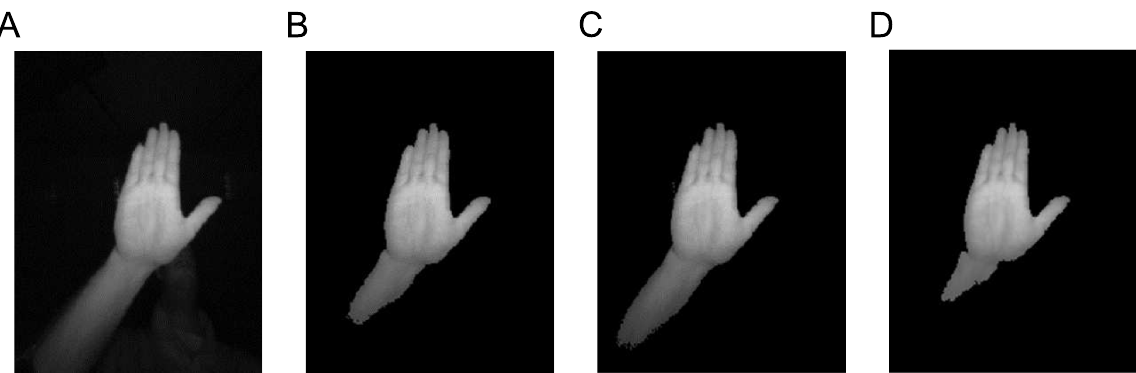
Fig 4. Hand image segmentation with three different thresholds. (A) original image, (B) result with Otsu’s threshold, (C) result with Otsu’s threshold plus one time the standard deviation, and (D) result with Otsu’s threshold minus one time the standard deviation.